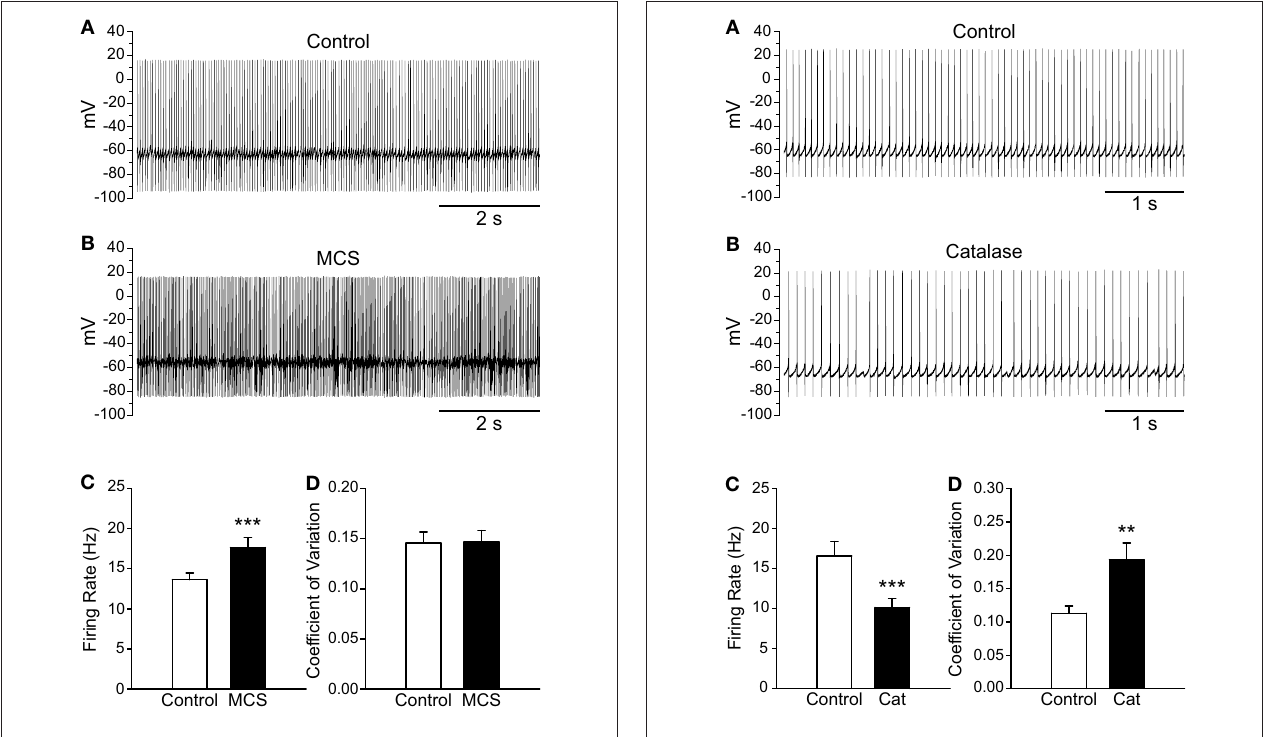
O with catalase slows the firing 2 2 O with 2 2